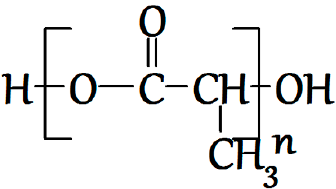
Figure 1. The structural formula of poly(lactic) acid (PLA).